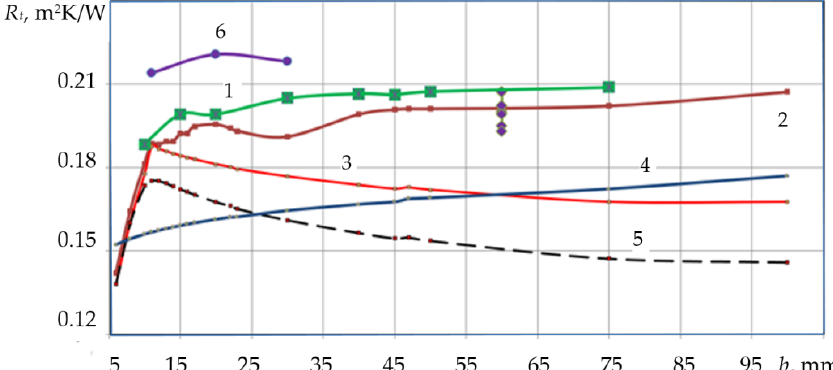
Figure 7. Thermal resistance of a double-glazed window depending on the thickness of the gap between the panes: 1—results of calculations in the CFD Fluent package; 2—results of calculations in the CFD Star CCM package; 3—results of calculations of the one-dimensional model; 4—results of calculations from Formula (2) with correction (3), where χ = 0.105Ra 0.3 ; 5—calculation results from Equation (2) with correction (3), where χ = (1 + (0.03303Ra 0.402 ) 11 ) 0.091 ; 6—results of calculations in Star CCM CFD package with the gap between the panes filled with argon